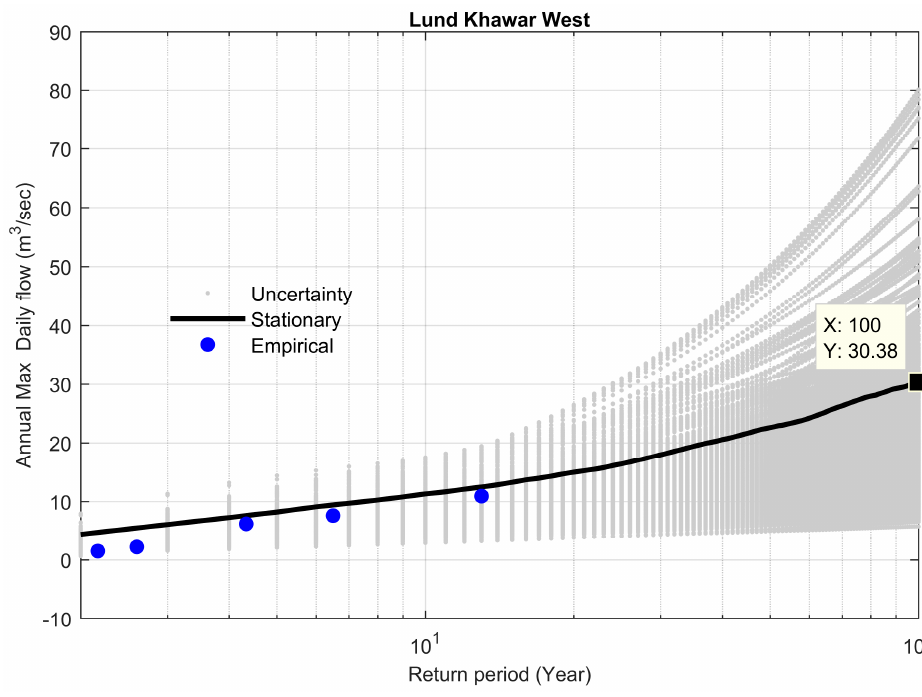
Figure 21. FFCs at site 22, along with stationary uncertainty bounds for the year 1996.